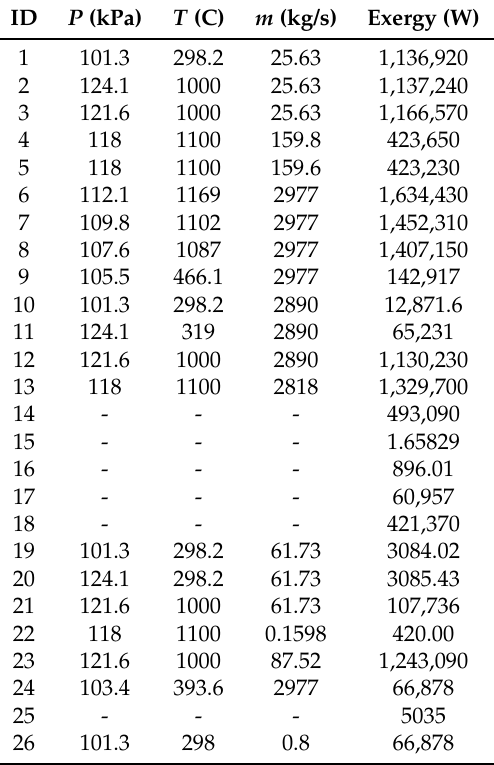
Table 4. Reference operating values for the simulation of the SOFC-VAR system.